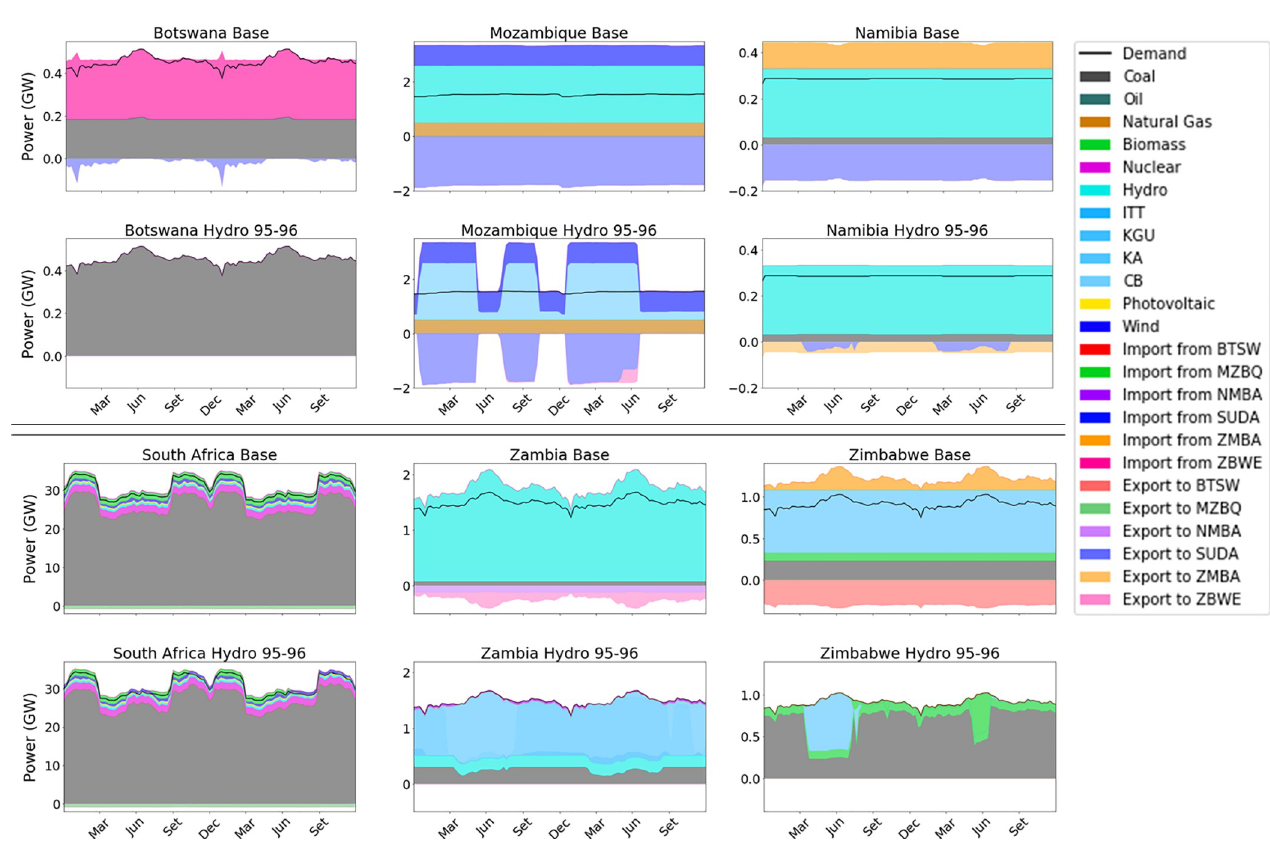
Fig 9. Dispatch analysis of Calliope_Base and Calliope_Hydro over the period 1995–1996 (driest scenario).